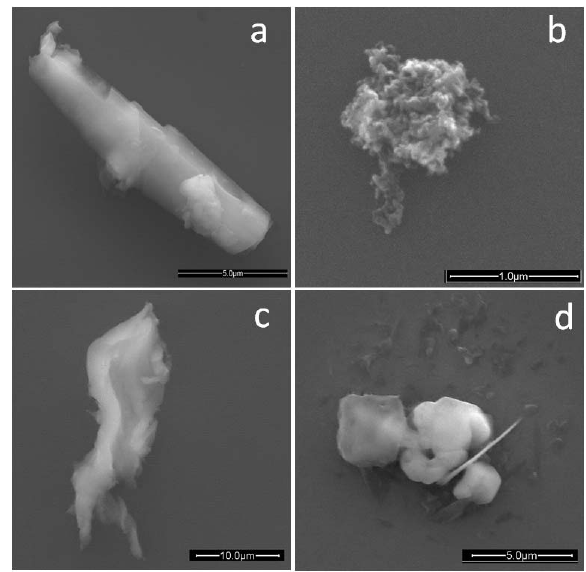
Fig. 3. Secondary electron images by ESEM of various ice nuclei that were previously identified by FRIDGE: (a) volcanic particle; (b) soot; (c) biological particle; (d) sea